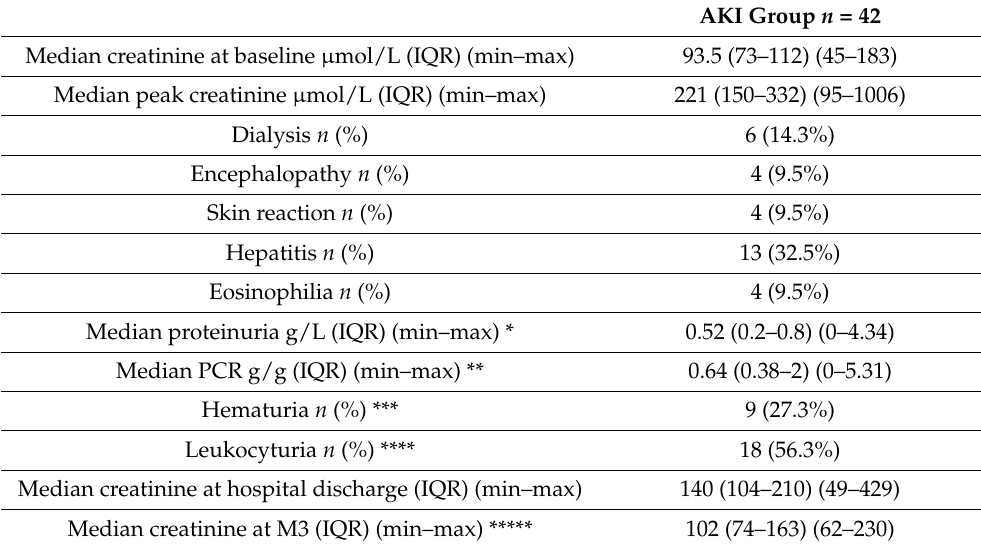
Table 2. Characteristics of AKIs observed in patients included in the CLOX-AKI study, CH Le Mans from 1 July 2012 to 1 July 2019.